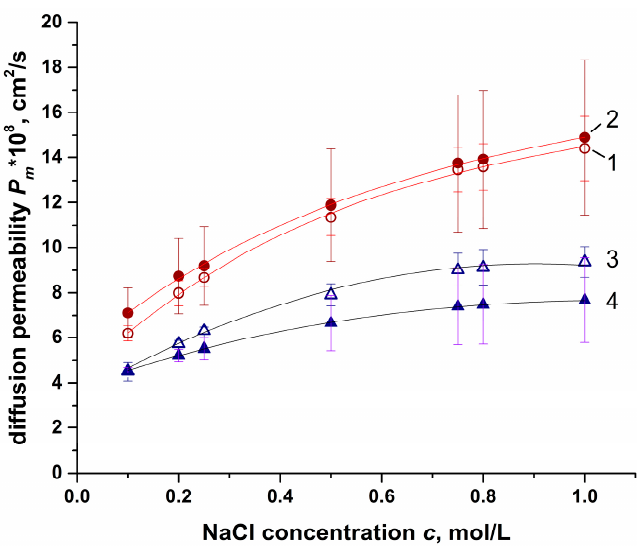
Figure 6. Concentration dependence of the mean diffusion permeability of the ion-exchange mem- branes from both batches. Membranes: 1–MK-40, 2–MA-41, 3–Ralex CM, 4–Ralex AMH.